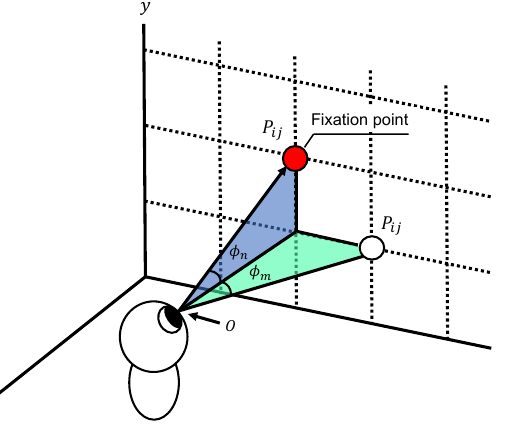
Figure 3. The rotation angles φ m and φ n between the fixation point and the other